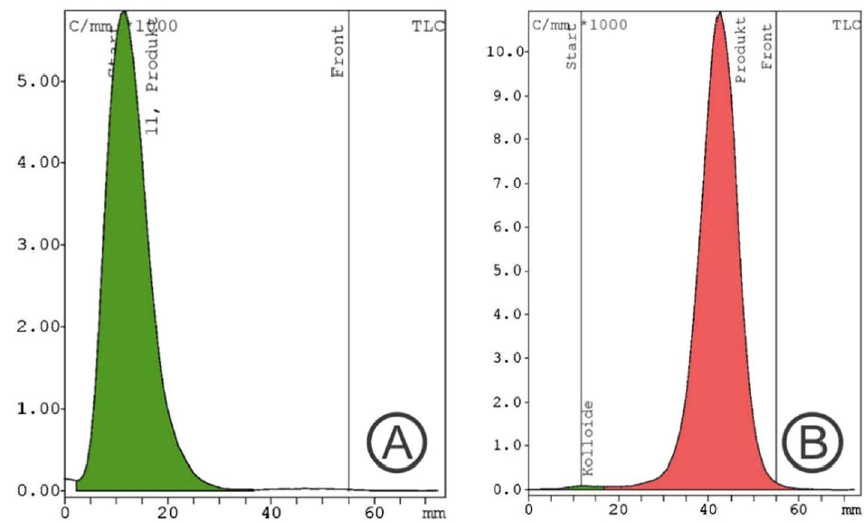
Fig. 6 Radiochemical purity analyzed with radio TLC scanner: A Stationary phase Tec-Control blue, (Biodex Medical Systems, USA); mobile phase: 0.1 M aq. sodium citrate. B Stationary phase iTLC-SG (Agilent Technologies Inc; USA); mobile phase: 1/1 mixture of 0.4 M aq. ammonium acetate/ethanol